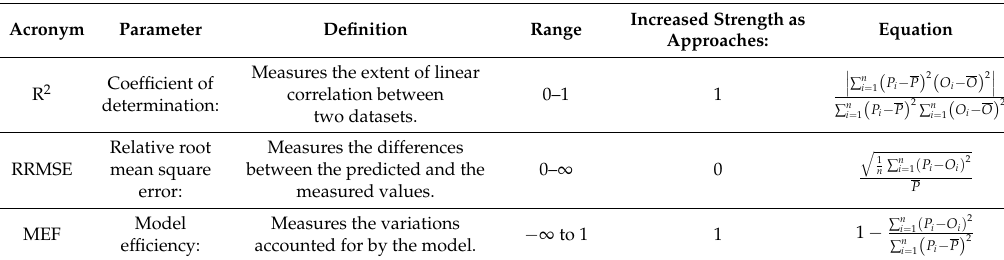
Table 2. Statistical parameters evaluated for each kinetic model